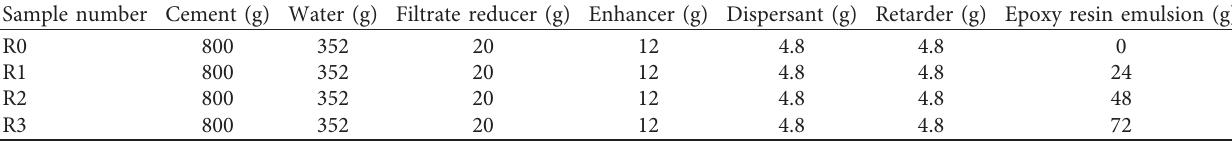
Table 1: Mix compositions of the resin modified cement